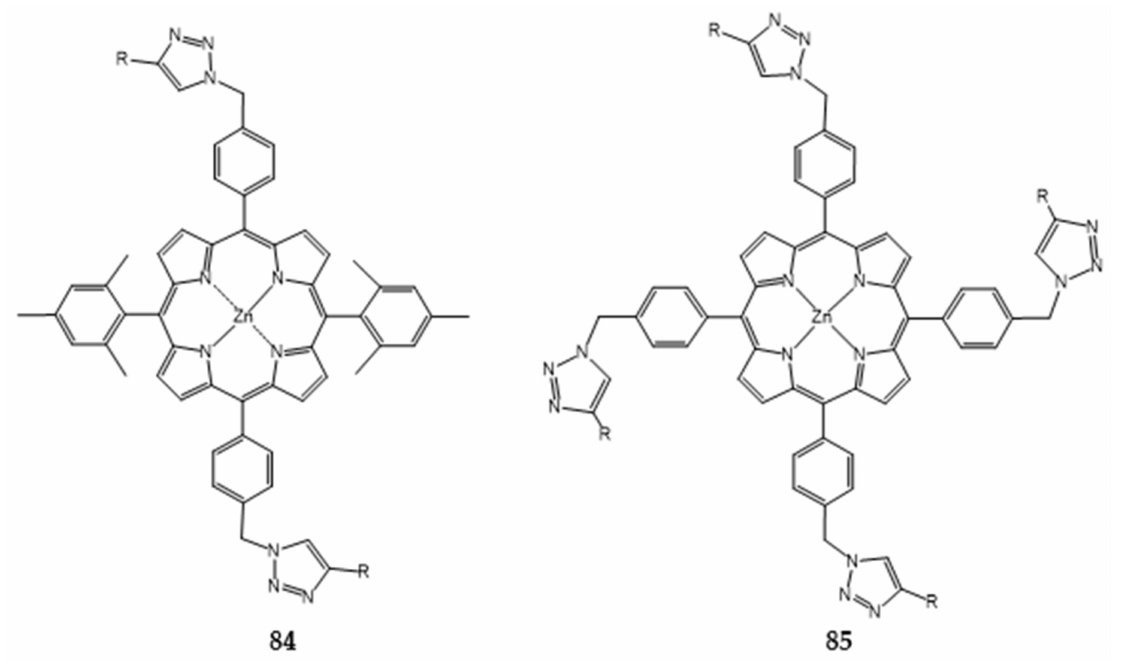
Figure 19. Structures of the meso-bis ( 84 ) and meso-tetra ( 85 ) carazolylphenyl substituted porphyrins.